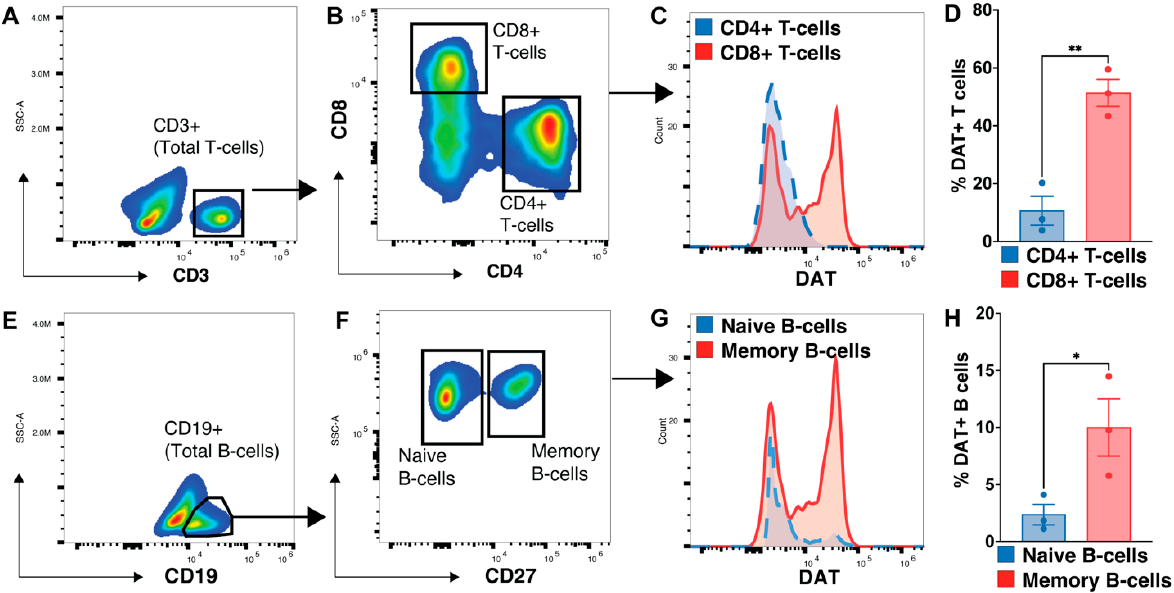
Figure 8. CD8+ T cells and memory B-cells in WT mice express increased DAT relative to other populations, possibly explaining the specific perturbations in B- and T- cell populations of DAT − / − mice. We observed an expansion in memory B-cells but a reduction in CD8+ T-cells in LPS-stimulated DAT − / − mice. Seeking an explanation for these contrasting observations, we conducted a PBMC immunophenotype of these cell populations to assess expression of DAT. ( A ) CD3+ T-cells were analyzed for expression of CD4 and CD8 ( B ). Each T-cell population was then examined for DAT expression ( C ). ( D ) In WT mice, significantly more CD8+ T cells express DAT than CD4+ T cells. ( E ) Similarly, total CD19+ B-cells were separated into naïve and memory B-cells ( F ), with each subset further assessed for DAT expression ( G ). ( H ) Significantly greater numbers of memory B cells express DAT than naïve B-cells. (Two-tailed unpaired t -test with Holm–Sidak correction; * p < 0.05, ** p < 0.01).